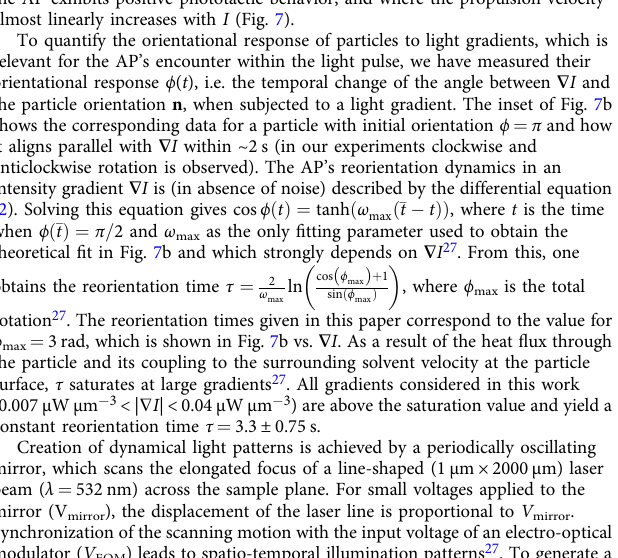
Fig. 8 Experimental realization of traveling light pulses. a Schematic drawing of the voltages applied to the mirror and the EOM (left) and the resulting time-dependent traveling laser pulse with propulsion velocity, and width w (right). b Dependence of the ν EOM on the pulse velocity u for ν mirror = 200